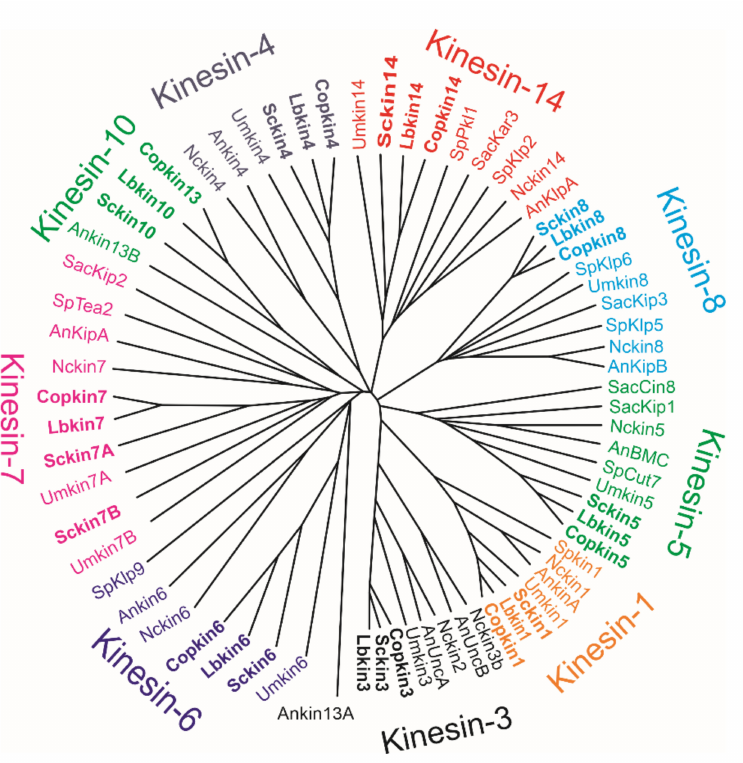
Figure 2. The tree is based on the alignment of the kinesin motor domains of the filamentous basidiomycetes Schizophyllum commune , Coprinopsis cinerea and Laccaria bicolor , basidiomycete smut Ustilago maydis , filamentous ascomycetes Aspergillus nidulans and Neurospora crassa , and yeasts Saccharomyces cerevisiae and Schizosaccharomyces cerevisiae . The GeneBank Accession or PID numbers of the kinesin proteins used for motor domain alignments are shown in Table 1. The basidiomycetes group into nine kinesin families known and identified in filamentous ascomycetes and yeasts. The filamentous basidiomycetes (Agaricomycetes) shown in bold are closely related in each kinesin family. The motor domains were aligned with Clustal Omega < Multiple Sequence Alignment < EMBL-EBI, and the tree was drawn with Phylogeny.fr.Drawtree